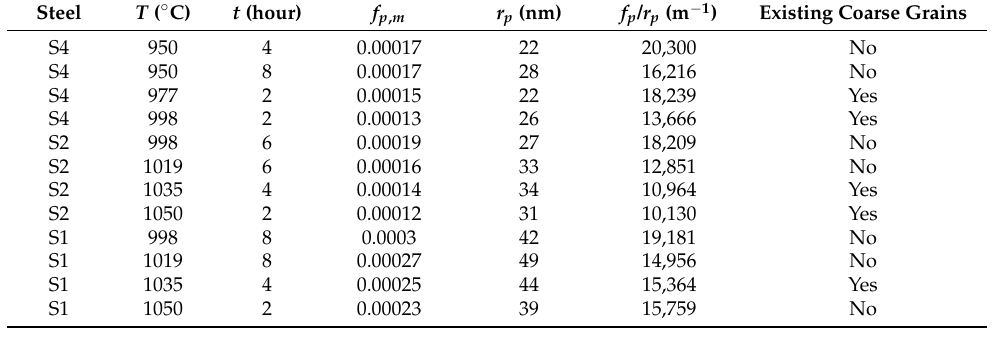
Table 4. The pseudocarburizing conditions, the calculated states of precipitates, and features of the final PAGSs of the verified experiments.